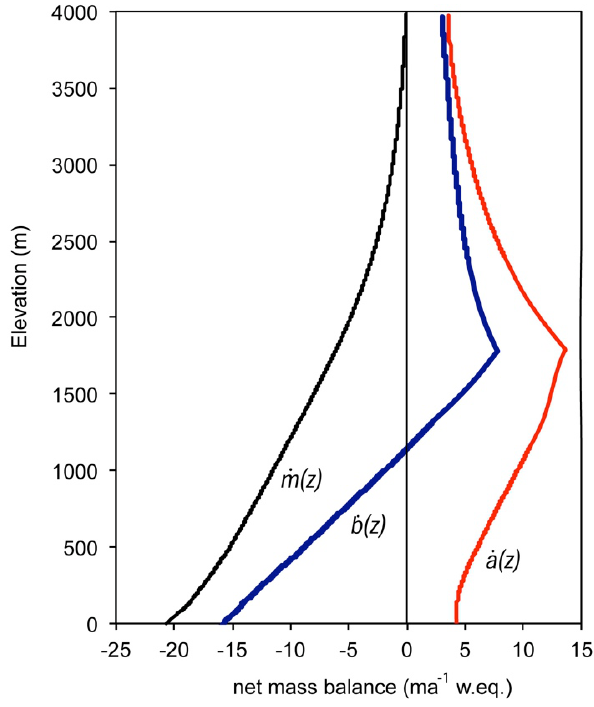
Fig. 8. Mean annual surface mass balance b(z) , accumulation c(z) and ablation a(z) derived from the mass balance model for the pe- riod 1960–2005, versus elevation. Mass balance is calculated using an orographic precipitation enhancement factor k(z) from Fig. 7 and input scenario #4 (Table 2).